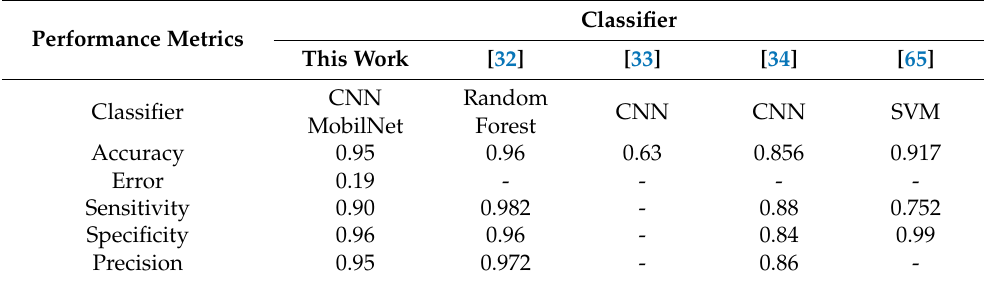
Table 5. Classification performances of the proposed work in comparison to other solutions reported in the